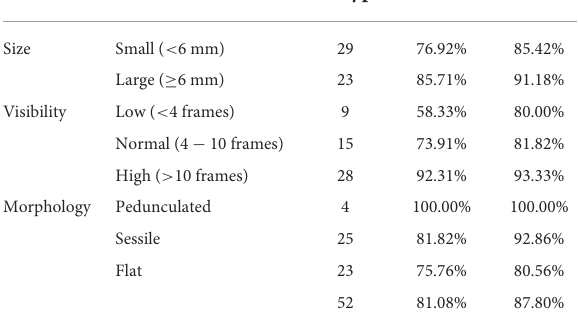
TABLE 1 Detection of polyps distinguishing by size, visibility and